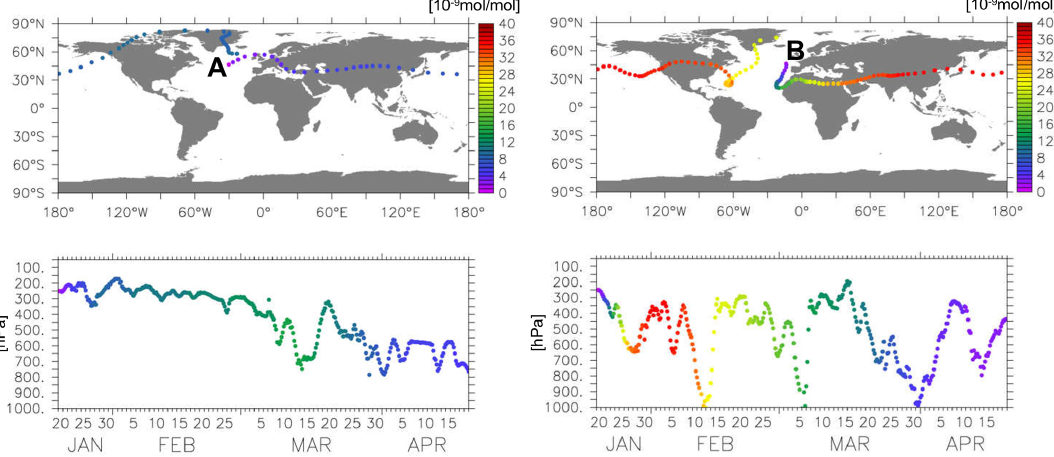
Figure 9. Evolution of the ozone mixing ratio along air parcel trajectories for two different emission locations in weather pattern W3: A (45 ◦ N and 30 ◦ W, left), which is west of the high-pressure ridge, and B (45 ◦ N and 15 ◦ W, right), which is in the high-pressure ridge. Top: geographical location of the air parcel in 6h intervals; the colour indicates the ozone mixing ratio [10 − 9 molmol − 1 ]. Bottom: temporal evolution of the altitude of the air parcels. For reasons of clarity, the top panels show a shorter period than the bottom panels (A: ∼ 15d, B: ∼ 27d, i.e. the time in which the air parcel surrounded the earth once).